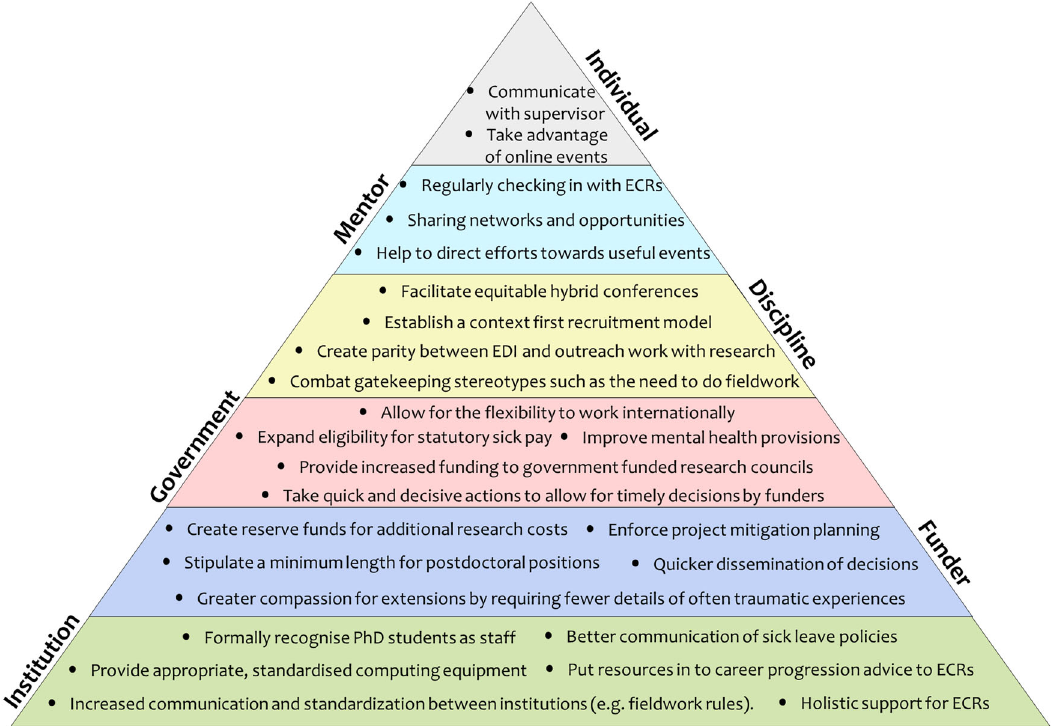
Fig. 1 A diagram indicating potential solutions to the problems faced by ECRs as a result of the COVID-19 pandemic. The tiers of the pyramid indicate the level at which we suggest these solutions could be implemented, tiers are structured by the number of actions that the stakeholder can take, not necessarily the hierarchy of responsibility as this will vary signi fi cantly between individuals ’